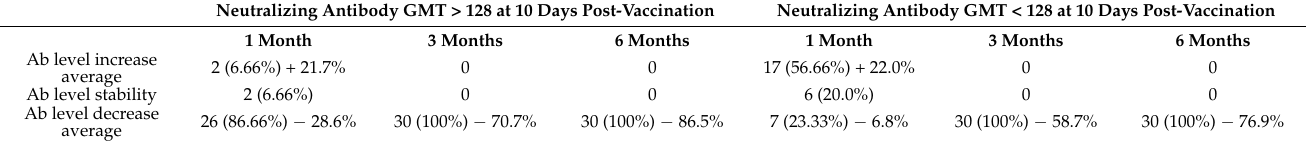
Table 1. Neutralizing antibody profiles 1, 3 and 6 months after the second dose of vaccination in 60 subjects compared with the antibody response developed at 10